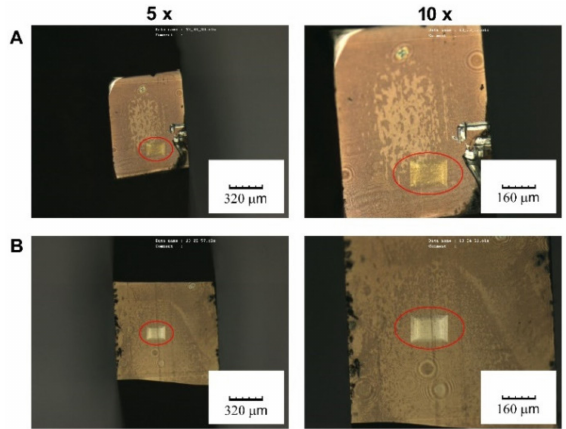
Figure 8. Visualization of the area decorated with AgNPs after its irradiation with SC laser: PET ( A ) and PEEK ( B ). The images were taken by confocal laser scanning microscopy using 5 × and 10 × objective